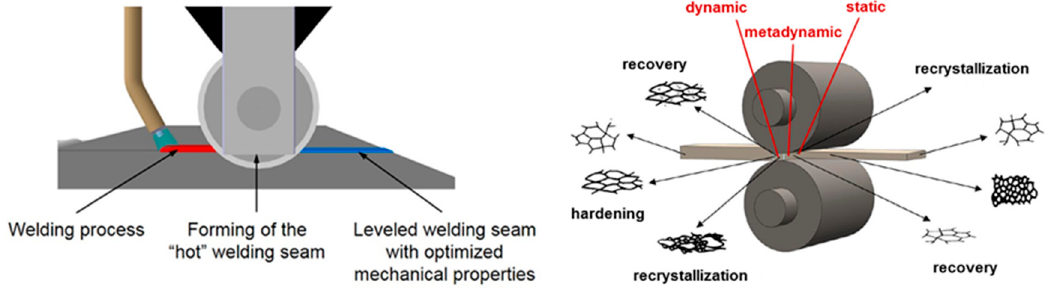
Figure 3. Schematic of the weld-forming process ( left ); softening mechanisms during and after hot rolling ( right ), according to Ullmann [15].